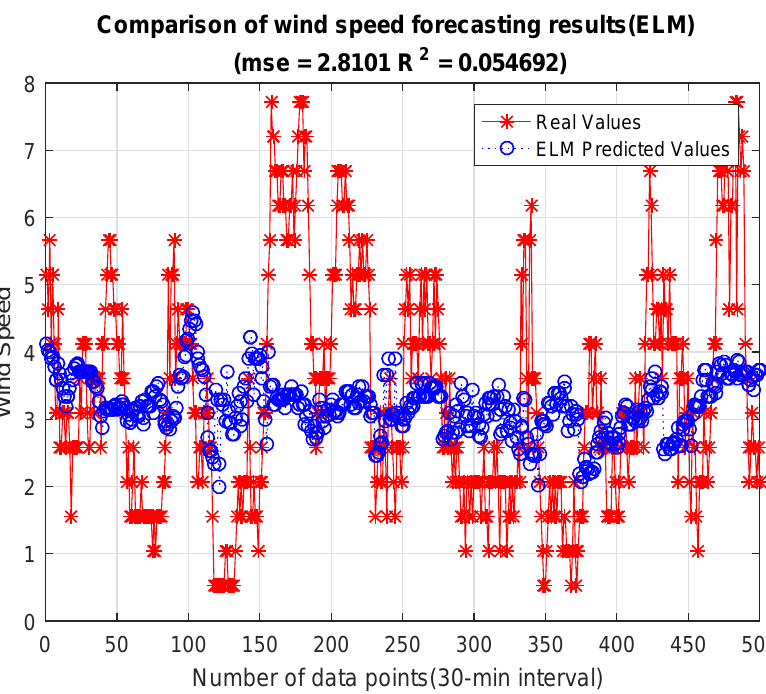
Figure 20. The portraits of comparison of wind speed forecasting results (ELM) in OSWFs in Yangshan port, Shanghai from 22 August 2017 to 22 August 2018 (number of predicted data pieces is 500).